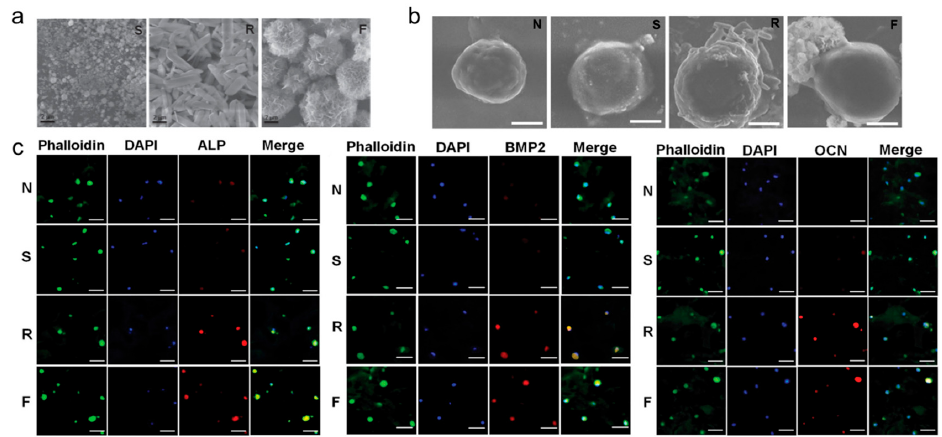
Figure 11. ( a ) SEM images of calcium phosphate crystals produced under different conditions. The scale bar is 2 μ m; ( b ) SEM images of interactions between cells and cell culture matrix of thermogels. The scale bar is 5 μ m; ( c ) Osteogenic biomarker production at protein level during the osteogenic differentiation of TMSCs. N represents the unmixed PEG-PAF. S represents the thermogel with calcium phosphate nanoparticles from Sigma-Aldrich. R represents the thermogel rod-like morphology calcium phosphate mesocrystals, F represents the thermogel flower-like morphology calcium phosphate mesocrystals (reproduced with permission from [49]).